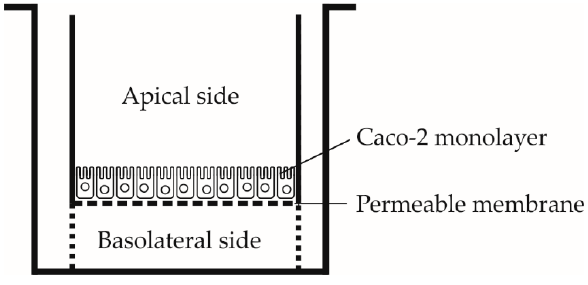
Figure 2. A schema of Transwell TM cellular system.